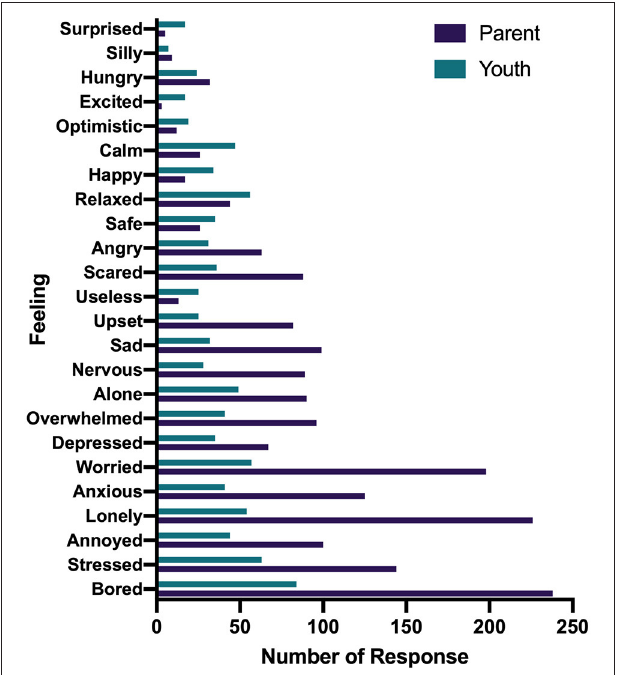
FIGURE 3 | Most prominent feeling during the COVID-19 pandemic reported by parents and youth.